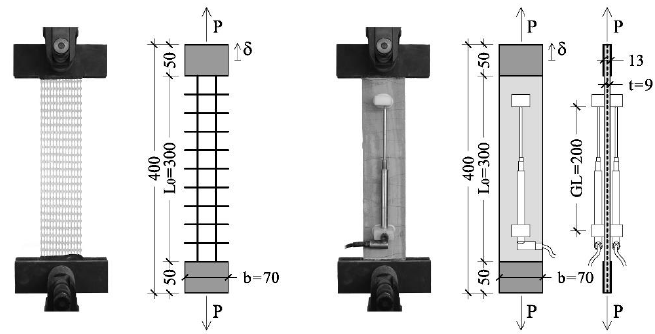
Figure 2. Fabric and textile reinforced concrete (TRC) specimens: uniaxial tensile test setups and nominal geometries (measures expressed in mm). Table 5. Mechanical properties of the investigated fabrics: average maximum tensile loads and efficiency parameters (70 mm wide specimens).